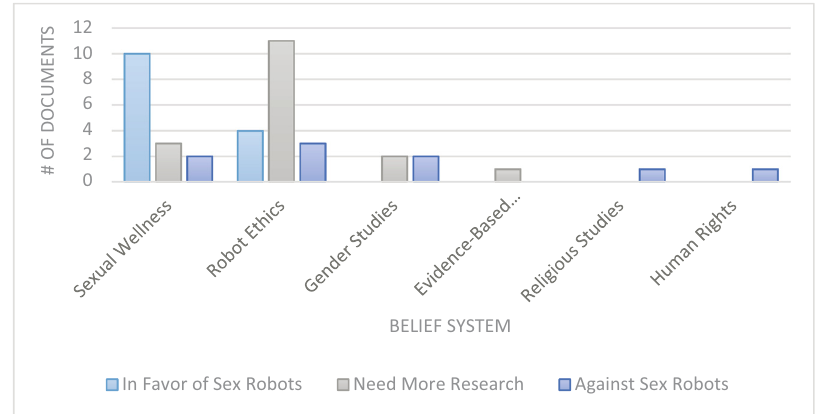
Figure 9: Sex robot - coded belief systems by coalition ( Scopus ) .